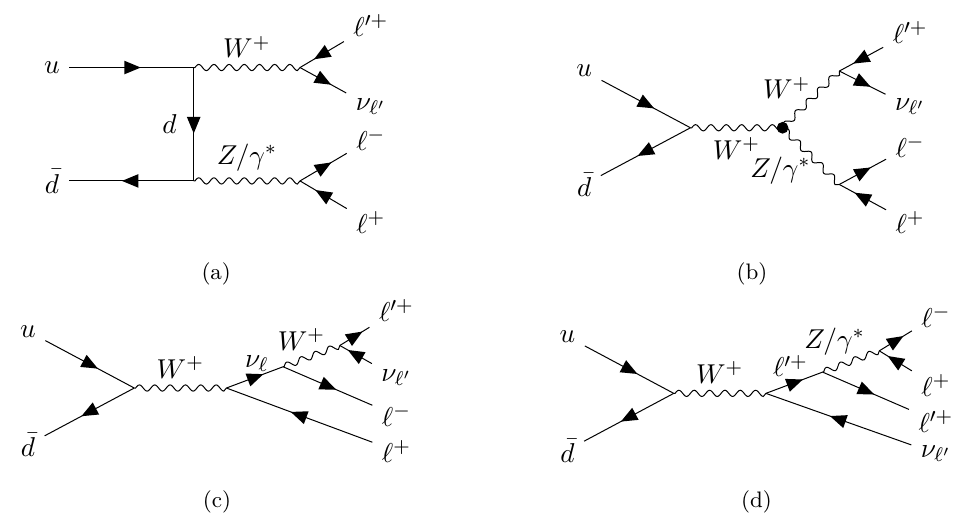
Figure 1. Sample LO diagrams for (a) t -channel W + Z production, (b) s -channel W + Z production and (c,d) DY-type W + Z production channels. The corresponding diagrams for W − Z production can be obtained via charge